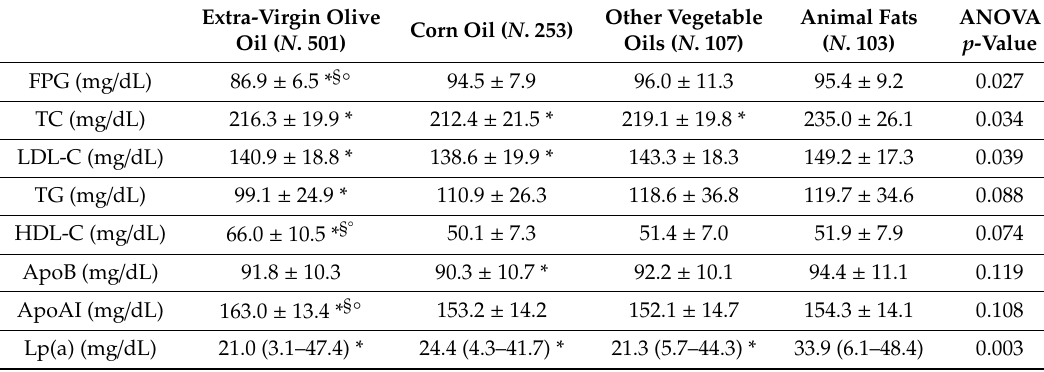
Table 4. Glyco-lipidic characteristics of subjects predominantly consuming di ff erent cooking fats in everyday